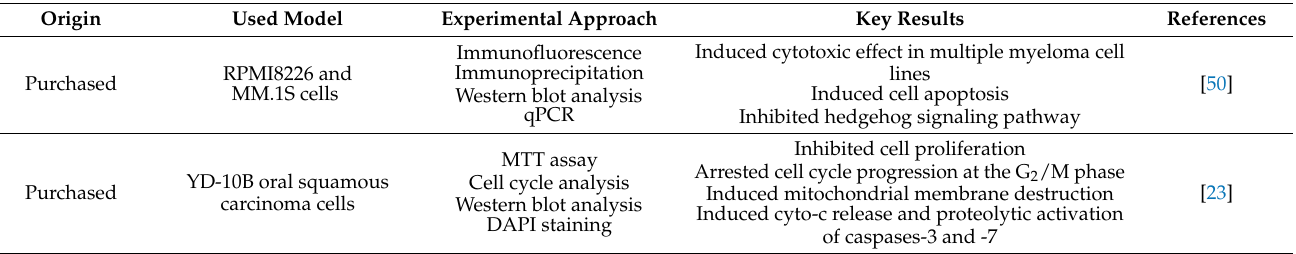
Table 4. Direct anticancer activity of trichostatin